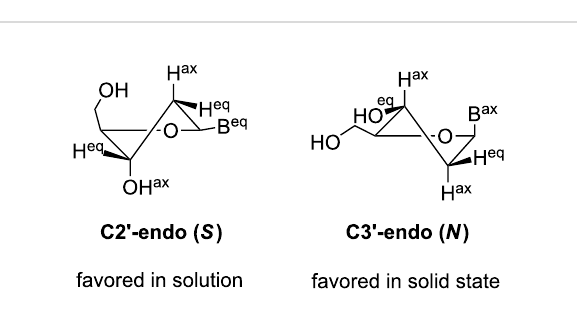
Figure 4: N - and S -conformation for cyclonucleoside 8 . B corre- sponds to nucleobase. ax: axial; eq: